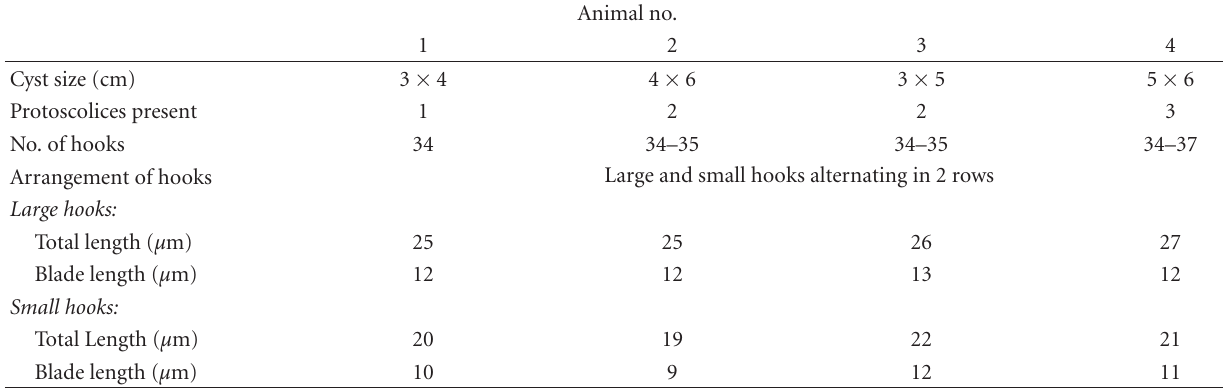
Table 2: Main features of the hydatid cysts found in goat liver. Animal